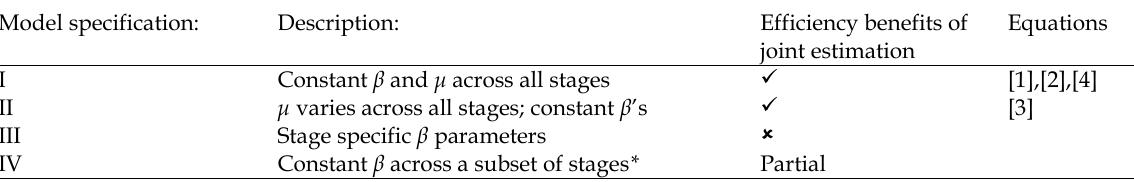
Table 1. Summary of model